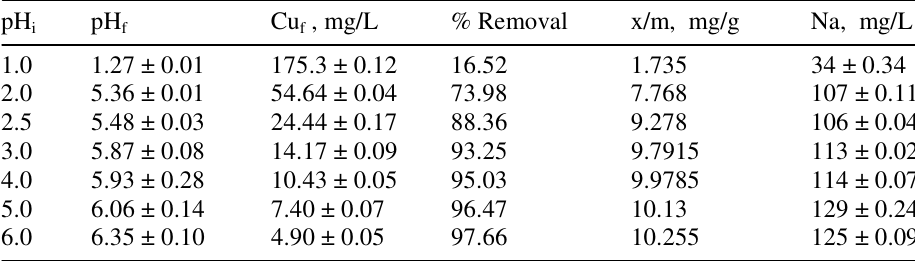
Table 2. Cu (II) removal from aqueous solution (Cu i = 210 ppm) adjusted at different pH after 24 h of sorption using 20 g/l